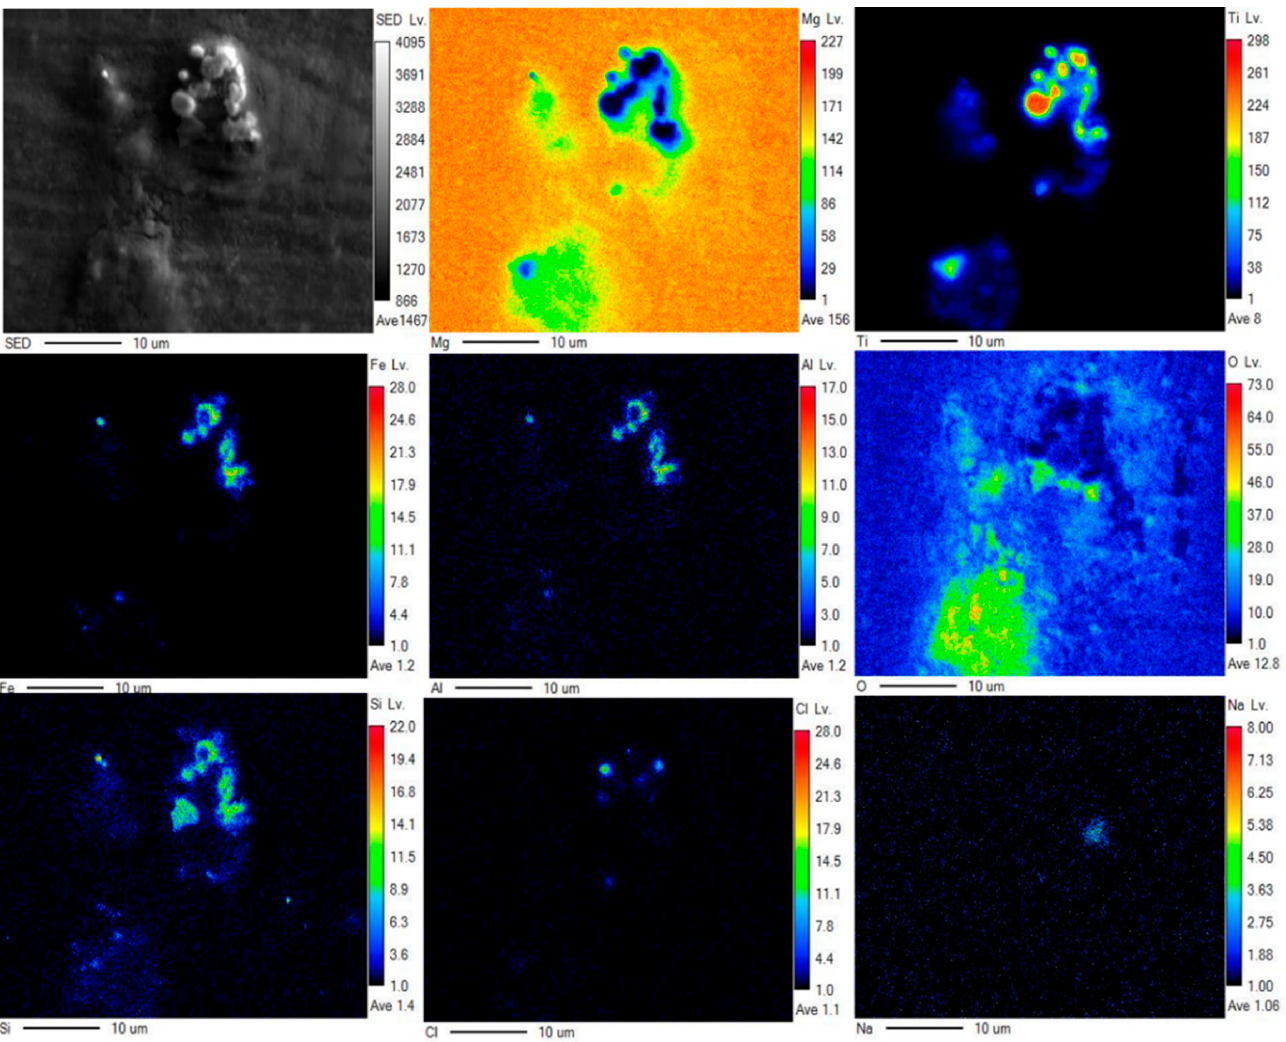
Figure 5. EPMA results for the electrolytically produced CM. According to the corresponding vapor pressure of each element, the separation co- efficient β of Mg from the impurities at different temperatures can be calculated, and the results are provided in Table 2. It can be seen that the separation coefficient β is less than 1 for the main impurity elements, such as Al, Fe, Mn, and Ni, in electrolytically produced CM, indicating that metallic Mg and the impurity elements can be easily separated. The activity coefficient γ of each component is 1 because the CM can be regarded as an infinite dilute solution with 7 impurities such as Pb, and Mn, as the solutes. This shows that Pb, Mn, Al, Fe, Ni, and Si have significant tendency to be separated from Mg but also different separation behaviors owing to the different β coefficients. However, the β coefficients of K and Na are always greater than one, denoting that K and Na are mainly concentrated